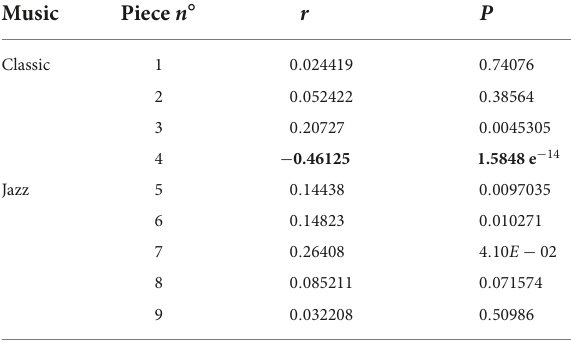
TABLE 1 Correlation analysis between music envelope and RR.